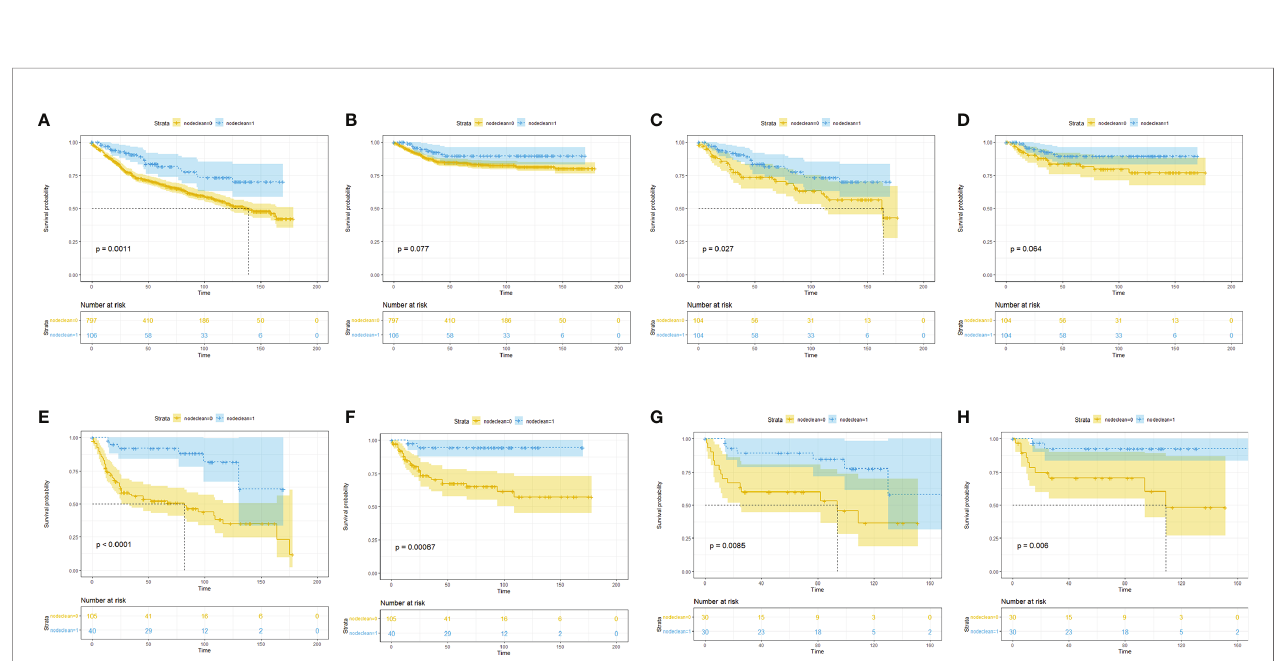
FIGURE 1 | Kaplan – Meier survival analysis for lymph node dissection (LND) in the propensity score matching (PSM) cohort. (A) Overall survival. (B) Cancer-speci fi c survival.